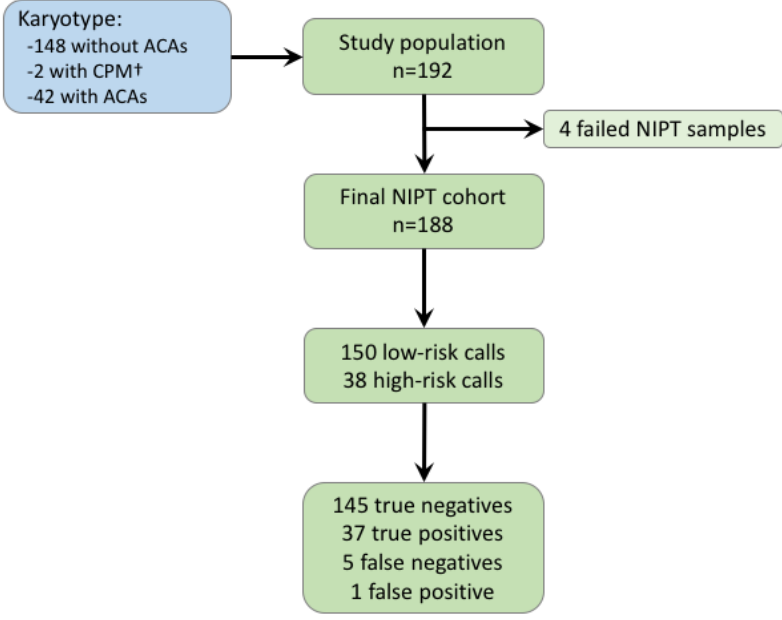
Figure 1. Overview of biobank samples. Overview of the study population, failed samples, and final NIPT cohort. †Two cases had placental discrepancy with abnormal cytotrophoblasts and normal fetuses. The first case was mosaic 46,XY,del(5)(p15)[7]/46,XY[12] by direct cytotrophoblastic karyotype and 46,XY by long-term culture and amniotic fluid culture. The second case was 47,XY, +der(13)t(11;13)(q12;q34),t(11;13) by direct cytotrophoblastic karyotype and 46,XY,t(11;13)(q12;q34) by long-term culture and amniotic fluid culture.